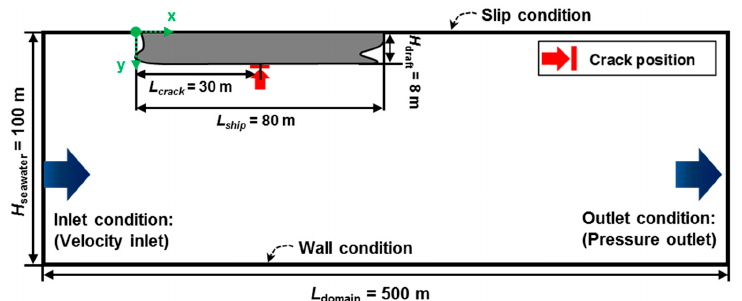
Figure 1. Schematic of the computational domain and boundary conditions.